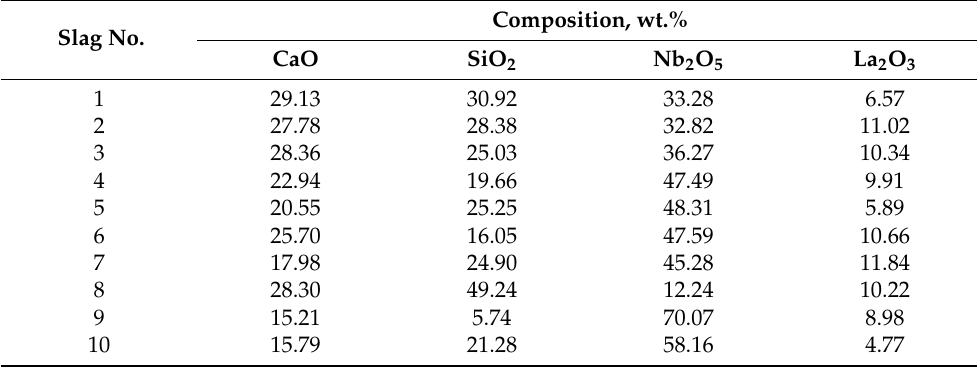
Table 1. Compositions of pre-melted slags.